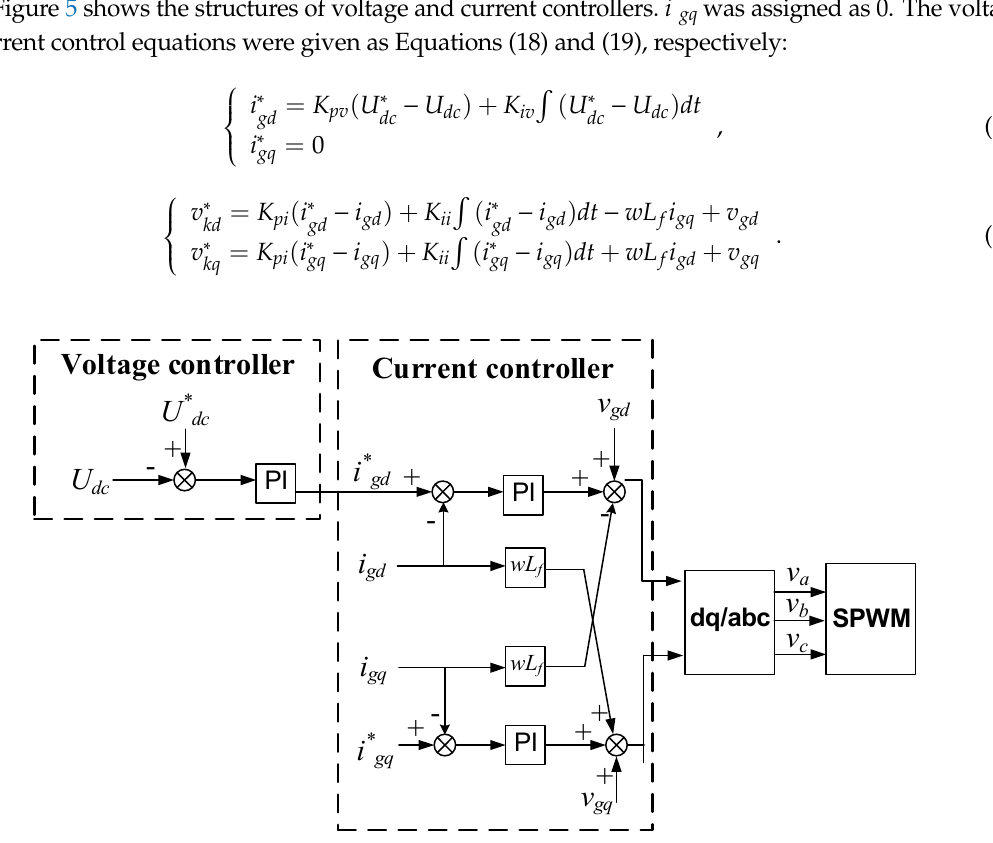
Figure 5. The structure of controllers. Symbols: U *dc , the reference value of a DC-side voltage; i *gd , the reference value of a d -axis current; i* gq , the reference value of a q -axis current; i gd , the d -axis current; i gq , the q -axis current; v gd , the d -axis voltage; v gq , the q -axis voltage; ω , the angular frequency of the system.